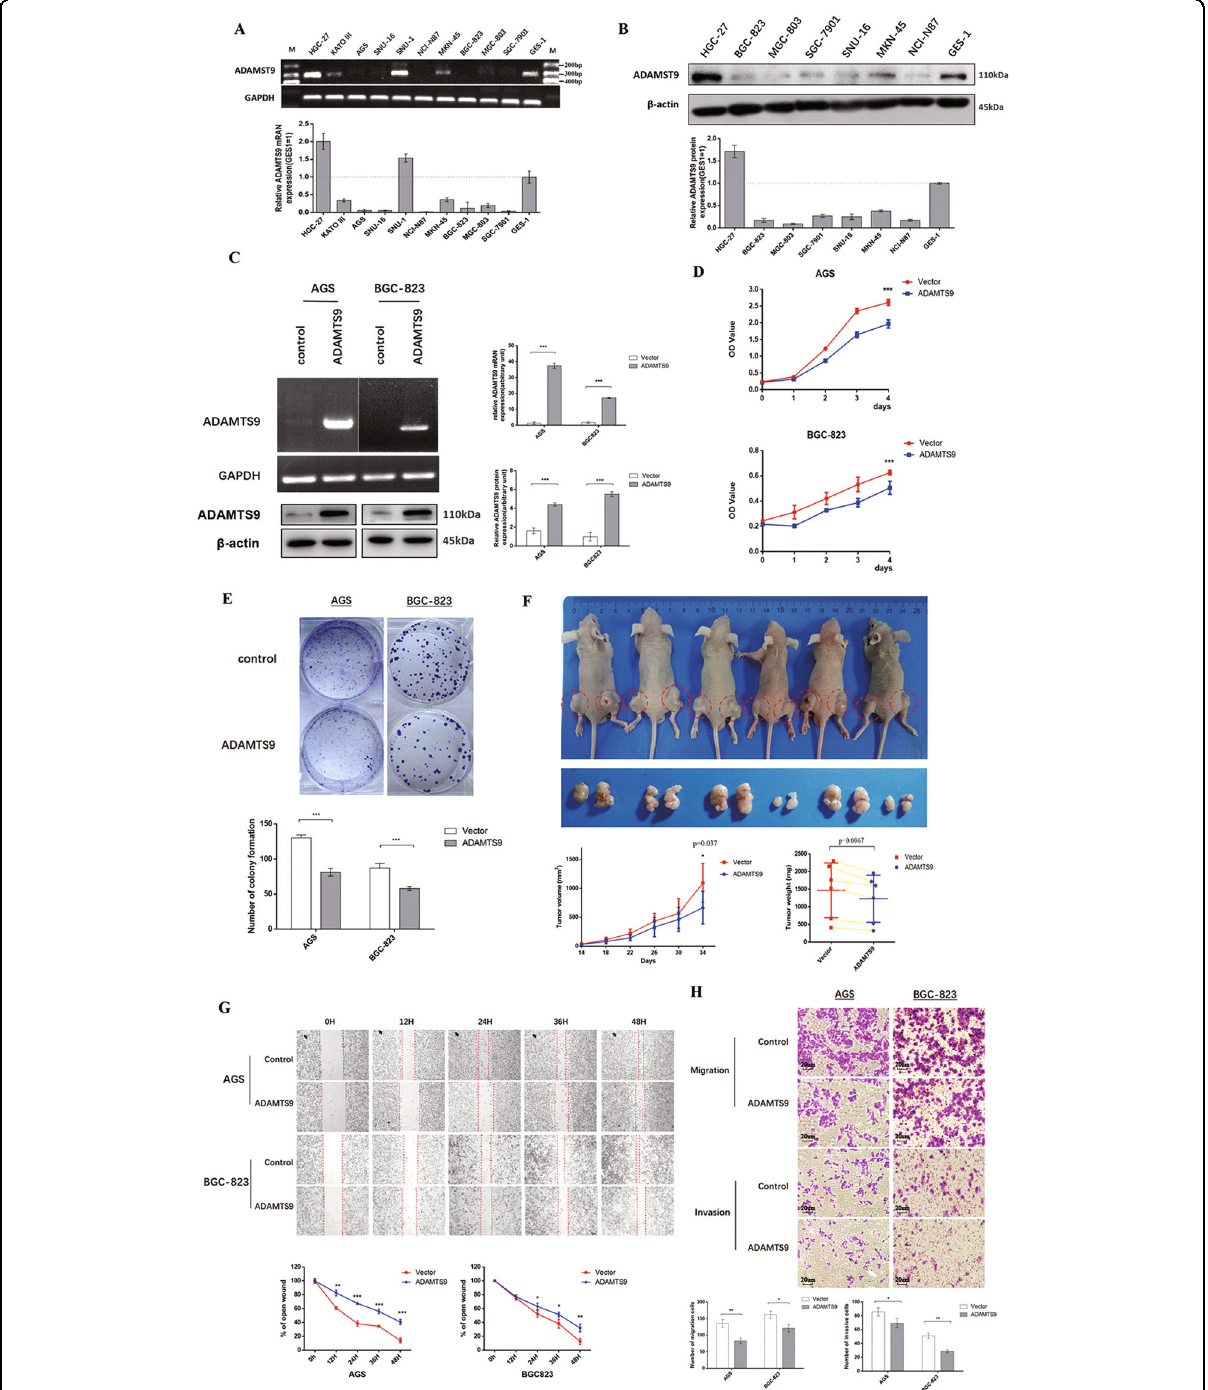
Fig. 2 ADAMTS9 attenuated malignant phenotypes in AGS and BGC-823 cells. A ADAMTS9 expression levels were examined by reverse transcriptase PCR assay; B and western blotting assay. C Expression levels of ADAMTS9 in AGS and BGC-823 cells transfected with ADAMTS9 overexpression plasmid and empty plasmid were analyzed by reverse transcriptase PCR and western blotting assay. D ADAMTS9 inhibits the cell growth in AGS and BGC-823 cells. E ADAMTS9 suppresses the colony formation in AGS and BGC-823 cells. F ADAMTS9 inhibited growth of tumors in vivo. Tumor growth curves and tumor weight shows the suppressive effect of ADAMTS9 in vivo. G ADAMTS9 impairs motile capacity in AGS and BGC-823 cells detected by wound healing assay (magni fi cation 40×); H and by transwell assay (magni fi cation